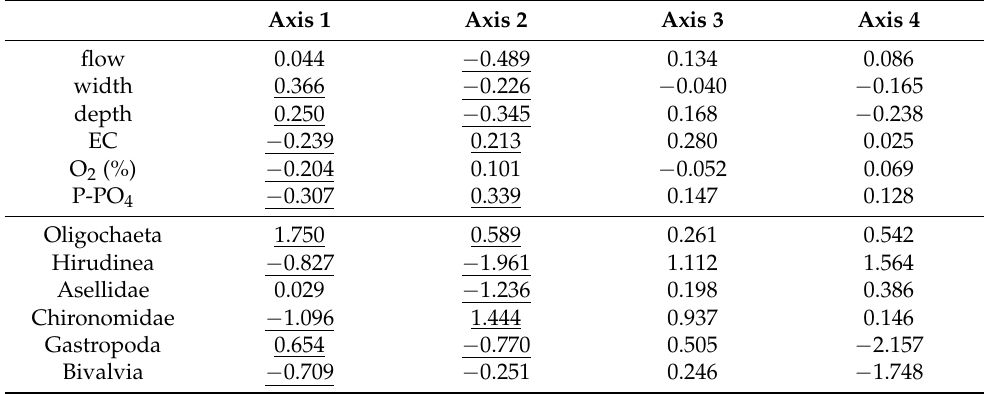
Table 5. Physicochemical factors and higher taxa in the CCA analysis. The data with underline shows important variable for Table 6. Regression. Only statistically significant correlations are shown.